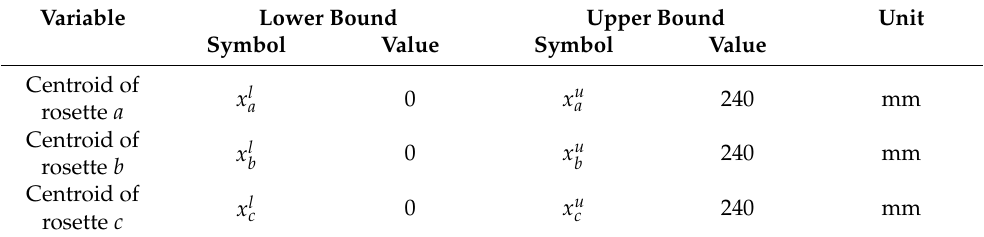
Table 2. Summary of the lower and upper bounds of the